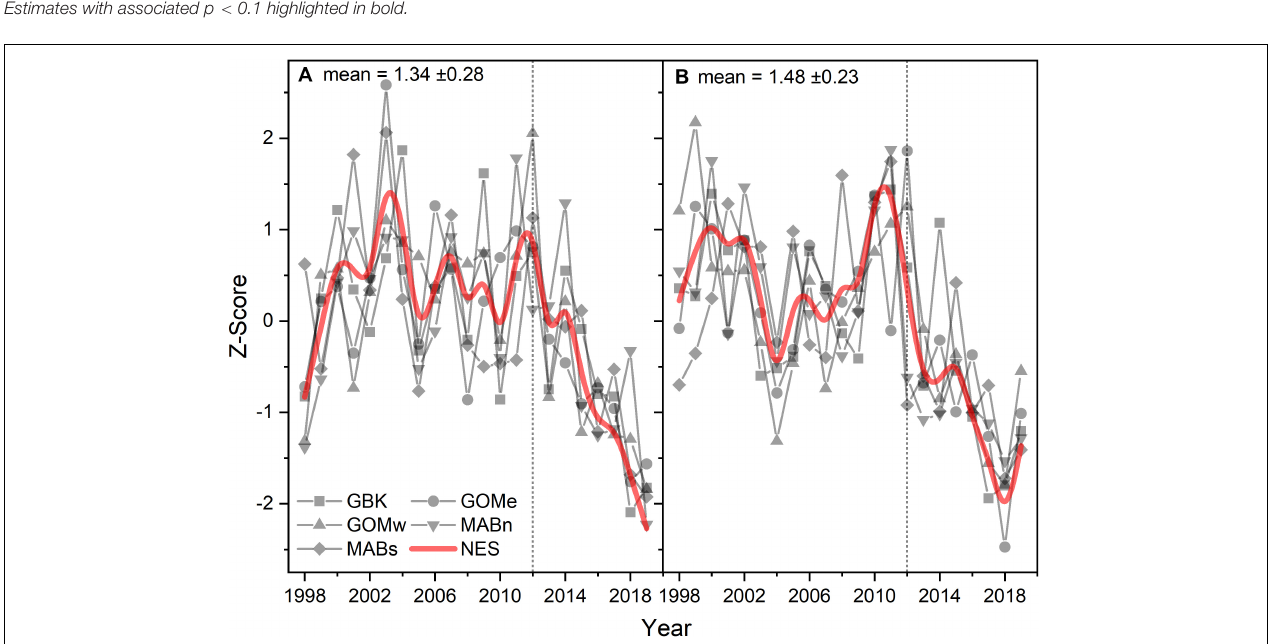
FIGURE 3 | Z-score of CHL for the first (A) and second (B) half of the year for the Northeast Shelf (NES) and NES subareas (NES, GBK, GOMe, GOMw, MABn, and MABs). The mean for each size class shown in the panel title with ± 1 SD; the NES time series is shown as a b-spline; 2012 is highlighted with vertical dotted line.